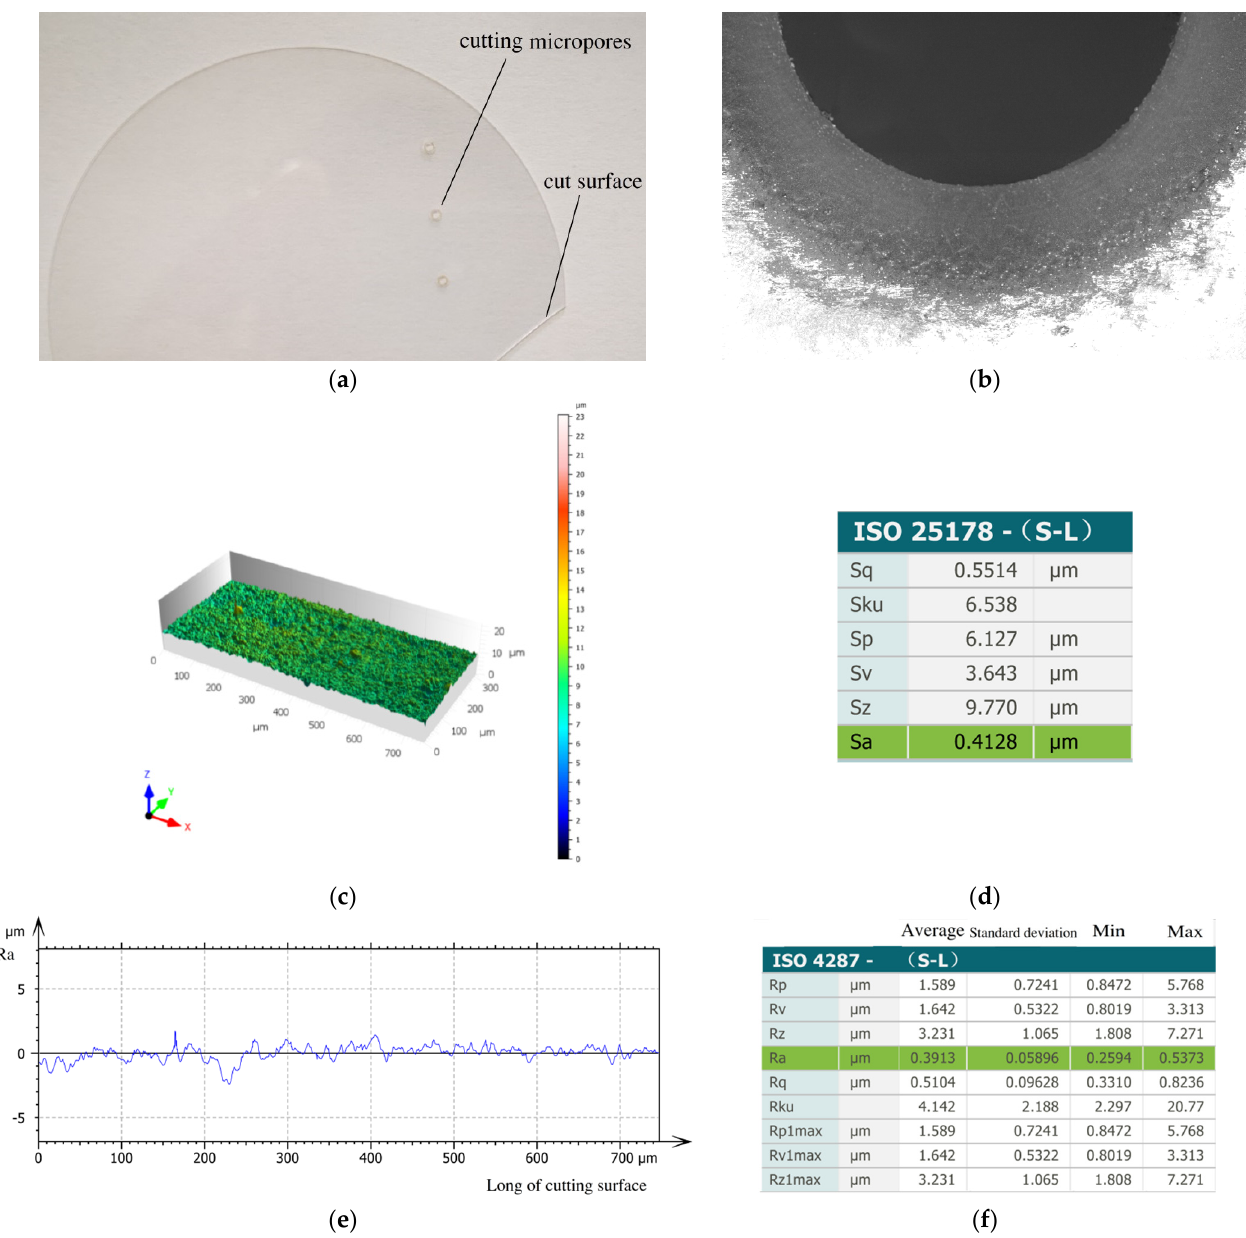
Figure 13. Test for double-beam cutting sapphire. ( a ) Photograph of cutting micropores. ( b ) SEM scanning of microporous sapphire surface. ( c ) 3D roughness of the cut surface. ( d ) Sa roughness of the cut surface. ( e ) Roughness of the cut surface. ( f ) Ra roughness of the cut